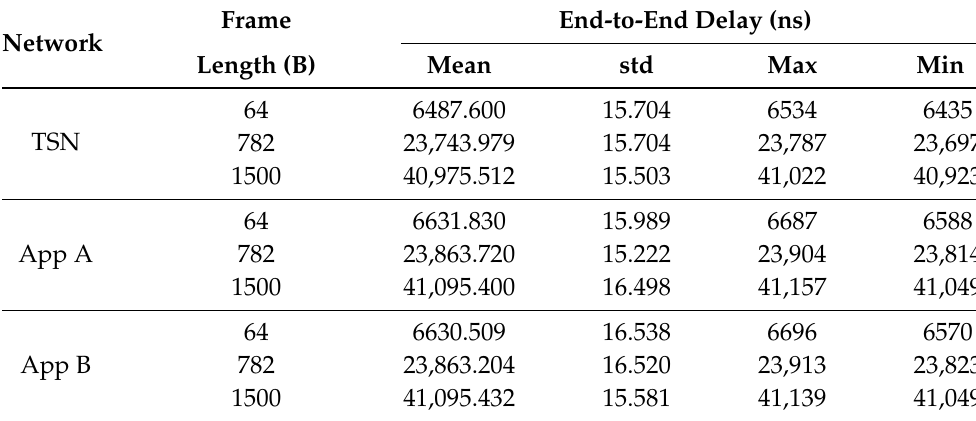
Table 2. End-to-end delay when transmitting a single frame using TSN, approach A and approach B through a 4-hop